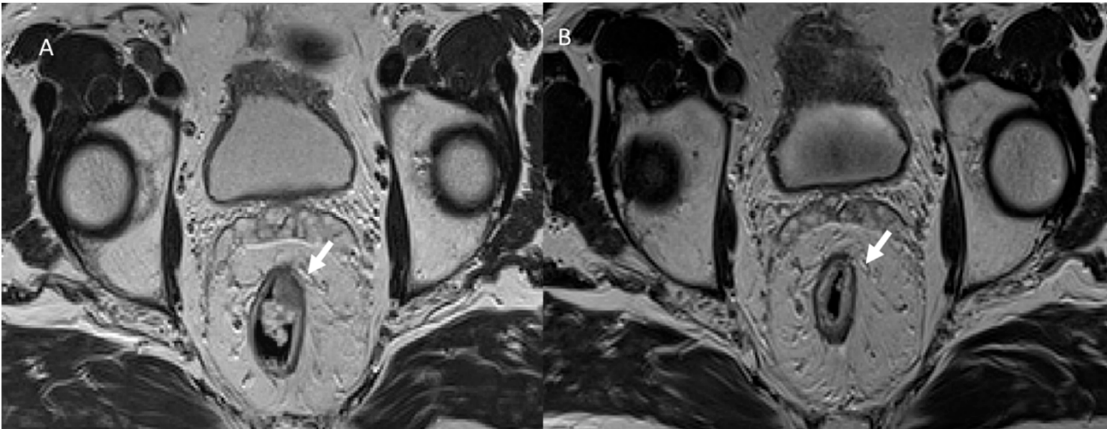
Figure 1. T2-W MRI assessment in pre ( A ) and post ( B ) neoadjuvant treatment for rectal cancer. In ( A ) pre-treatment, the arrow shows a T2 rectal tumor, with the radiological complete response in ( B ) (arrow).